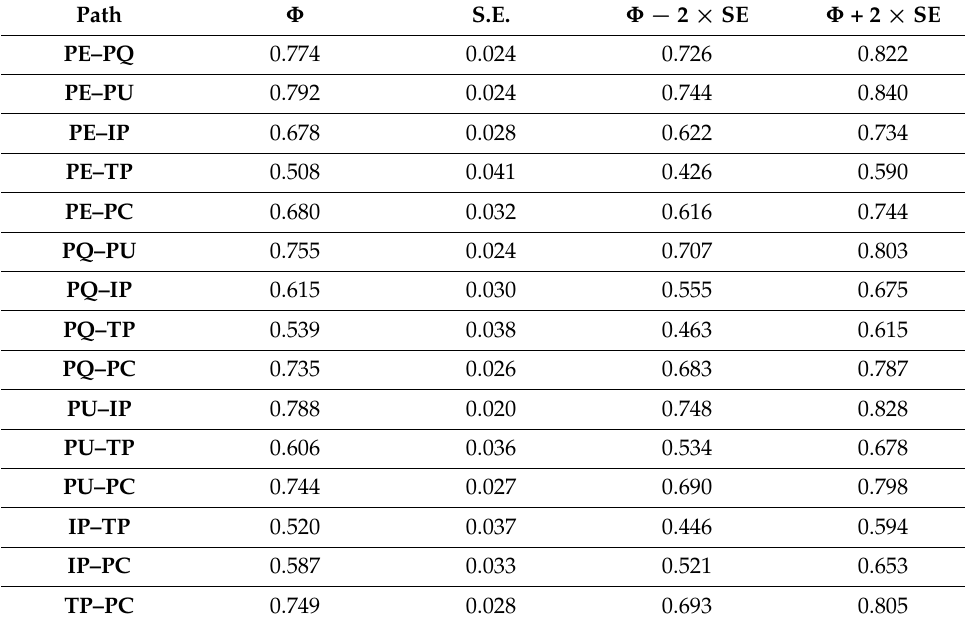
Table 3. The results for discriminant